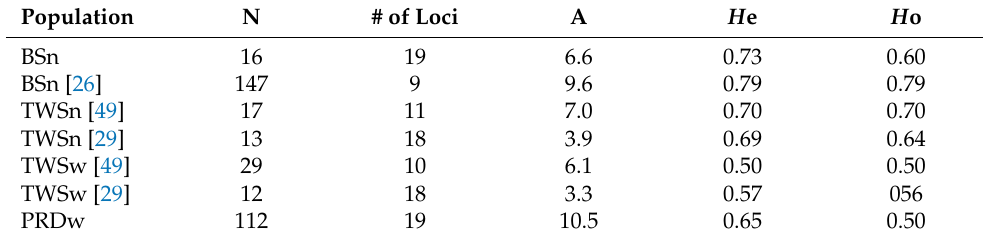
Table 1. Molecular diversity of four finless porpoise populations from China’s coastal waters. Population N # of